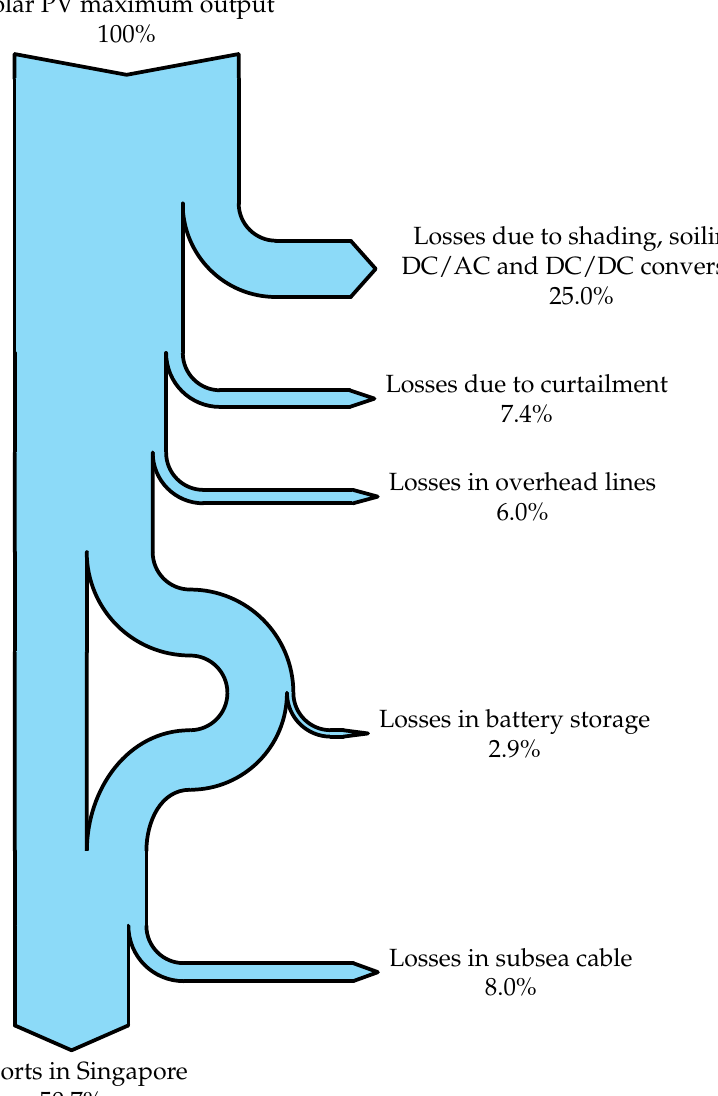
Figure A1. Sankey diagram showing the energy flows and the losses along the way from Tennant Creek to Singapore in the reference